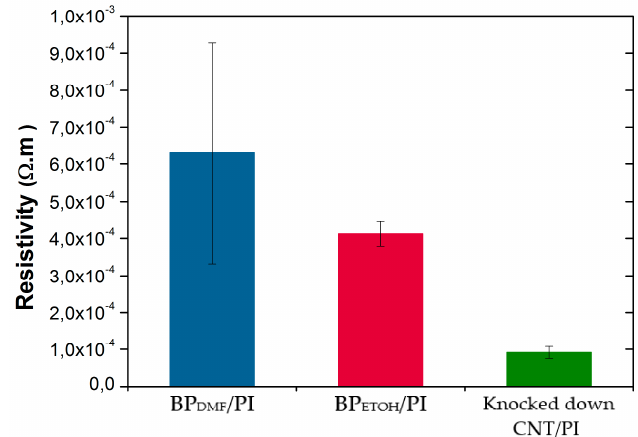
Figure 3. Electrical resistivity values of the BP DMF , BP ETOH , and knocked-down CNT samples.